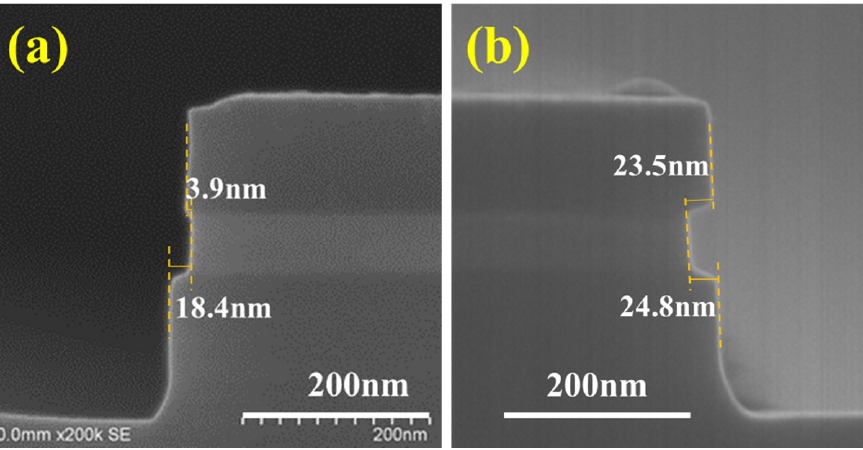
Figure 3. The SEM cross-section images of Sample I after digital etching at 40 cycles with ( a ) 30% H 2 O 2 -dBOE q-ALE and ( b ) 31.5% HNO 3 -dBOE